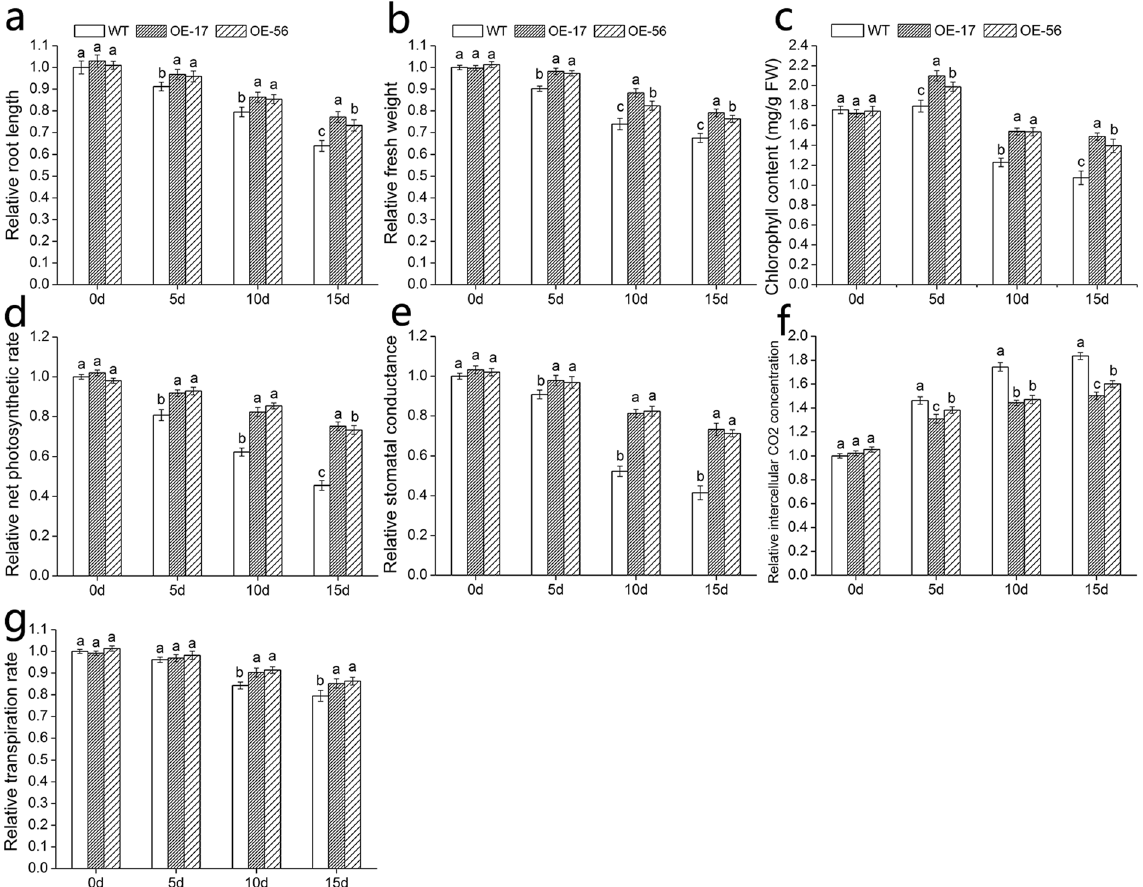
Figure 5. Assay of root length, fresh weight, chlorophyll content and leaf gas exchange parameters in DgWRKY5 transgenic lines and WT under salt stress. ( a ) Relative root length. ( b ) Relative fresh weight. ( c ) Chlorophyll content. ( d ) Pn. ( e ) Gs. ( f ) Ci. ( g )